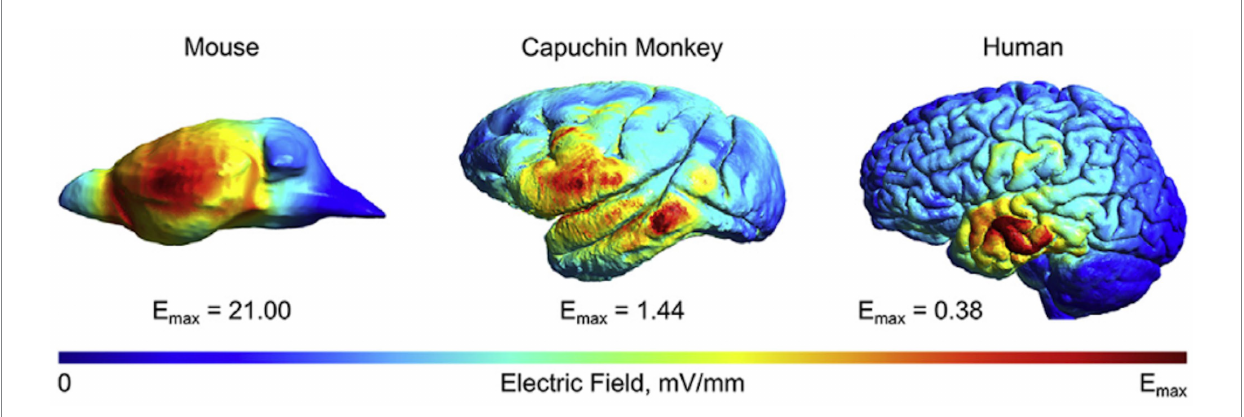
FIGURE 2 Different field values across species. A comparison of the normalized electrical fields induced by transcranial electrical stimulation in mice, monkeys, and humans. The electrode montage was identical across species, and the current intensity was set to the same level. It can be seen that the maximum field strength of the three models decreases exponentially with increasing brain volume. The figure has been adapted with the authors’ and publisher’